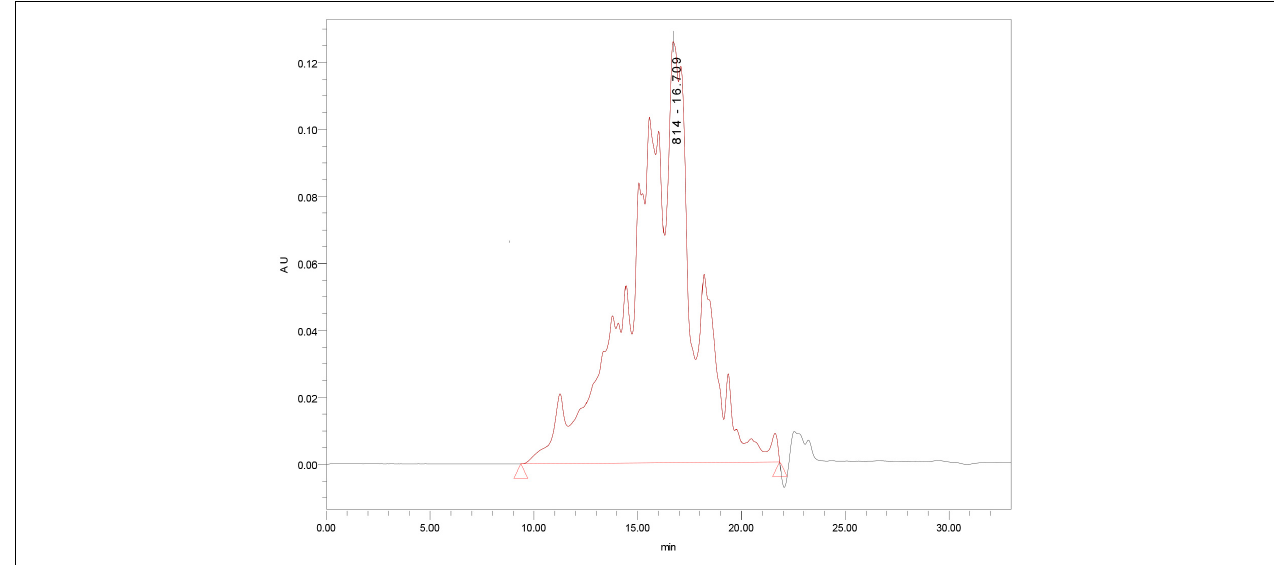
FIGURE 1 | The molecular weight distribution of MBPs.